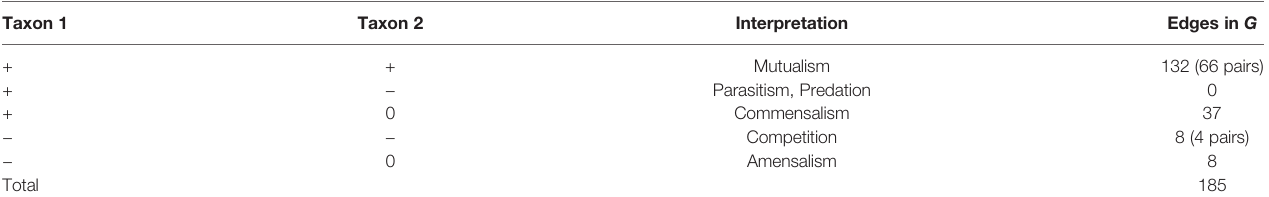
TABLE 3 | Interpretation of the sign of a pairwise association value from ^ T = sign ( ^ b ), following Faust and Raes (2012), and number of edges (and pairs) of that association type in G . Taxon 1